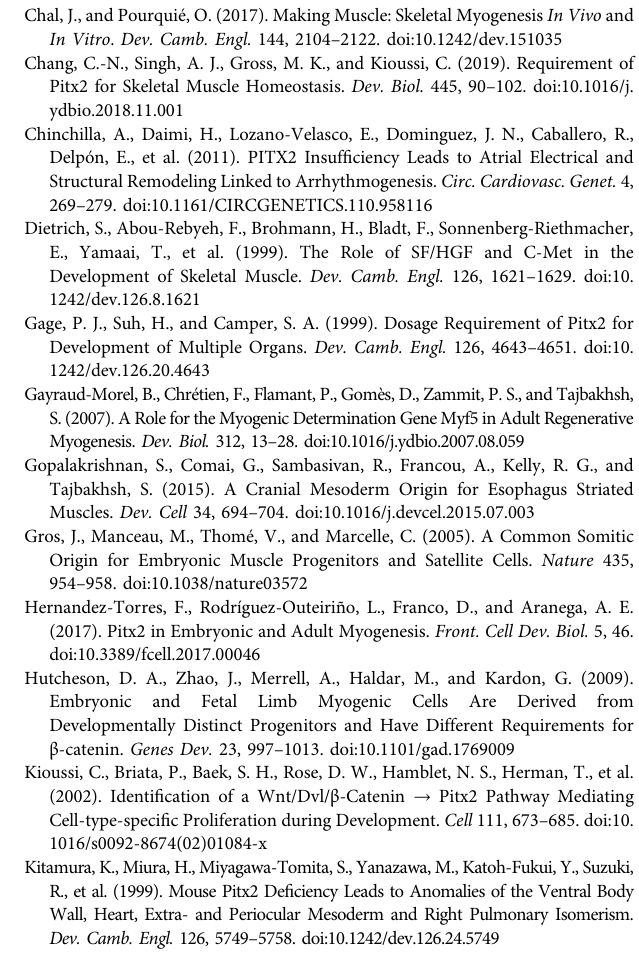
Supplementary Figure S1 | (A) Immunoassaying for Pitx2, Pax3 and Myf5 in the DMT at E10.5. (B) qRT-PCR analyses for Pitx2 expression of E10.5 and E18.5 Pax3 Cre/Wt /Pitx2 -/l- mutants embryos in the dermomyotome and limbs. (C) Representative images showing the presence of DORV (arrow) Pax3 Cre/Wt / Pitx2 − / − embryo at E12.5. ***p < 0.001 ( n = at least 3 embryos per condition). Supplementary Figure S2 | (A) Pitx2 expression levels of Pitx2c in Pax3 Cre/Wt / Pitx2 Wt/- heterozygote mice. (B) Pitx2 expression levels in the TA muscles